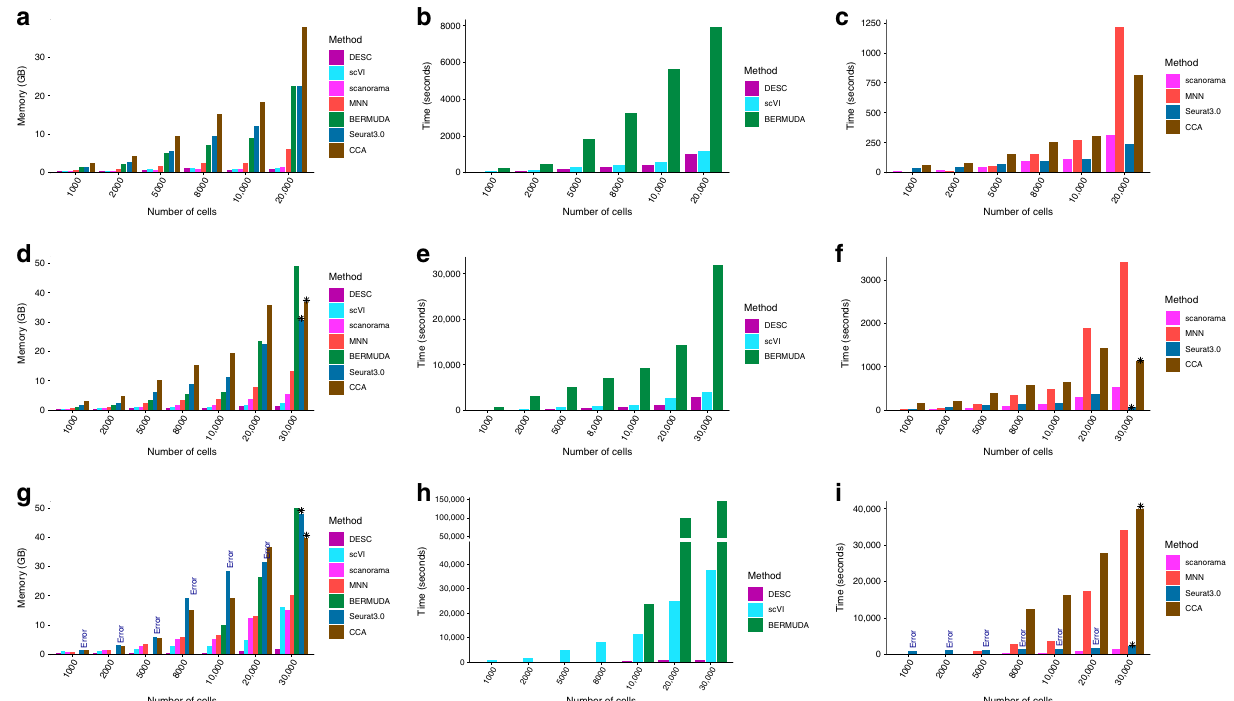
Fig. 9 Comparison of memory usage ( fi rst column) and running time (second and third columns). a – c The number of batches for analyzed samples is 2. Analyzed data were from Kang et al. 18 . d – f The number of batches for analyzed samples is 4. g – i The number of batches for analyzed samples is 30. For d – i the analyzed data were form Peng et al. 10 in which there are four batches when taking macaque id as batch de fi nition and 30 batches when taking sample as batch de fi nition. Because DESC, scVI, and BERMUDA are deep learning based methods, we put them together for ease of comparison. Remark: the reason that the running time of batch = 30 is smaller than that of batch = 4 for DESC is because when the data were standardized by sample id (i.e., when batch = 30), the algorithm converged quickly before reaching to the maximum number of epochs (300). The “ Error ” in the bar plot in g and i indicates that there was an error when using Seurat 3.0. This is because the numbers of cells in some batches are very small. The “ asterisk ” above the bar plot in d , f , g , and i indicates that the corresponding method broke due to memory issue (i.e., cannot allocate memory). Therefore, the recorded time is the computing time until the method broke. When the number of batches is 30, BERMUDA always throws out an error when the number of cells is less than